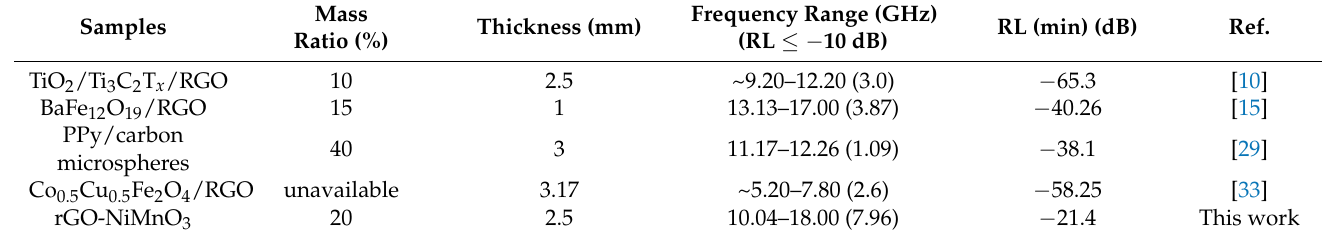
Table 1. Microwave absorption properties of carbon-based nanocomposites.